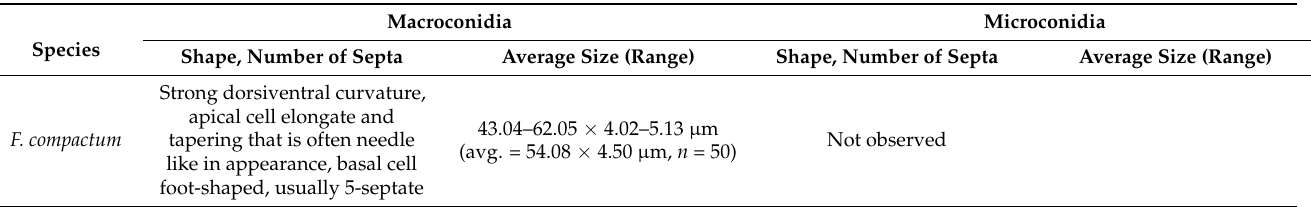
Table 3. Description of conidia of Fusarium fungi cultivated on